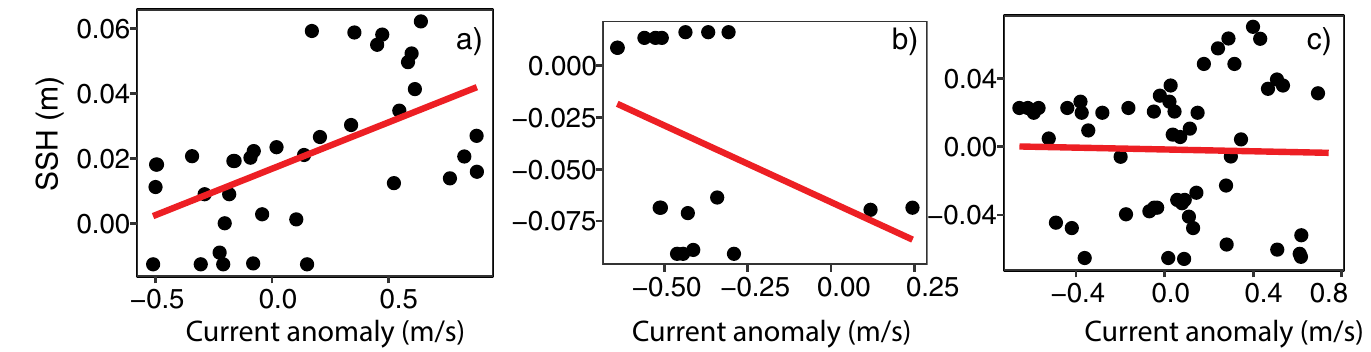
Fig 13. The relationship between Sea Surface Height (SSH) anomaly and surface current velocity anomaly in the Pemba Channel during a) IN, b) NE and c) SE monsoon seasons.